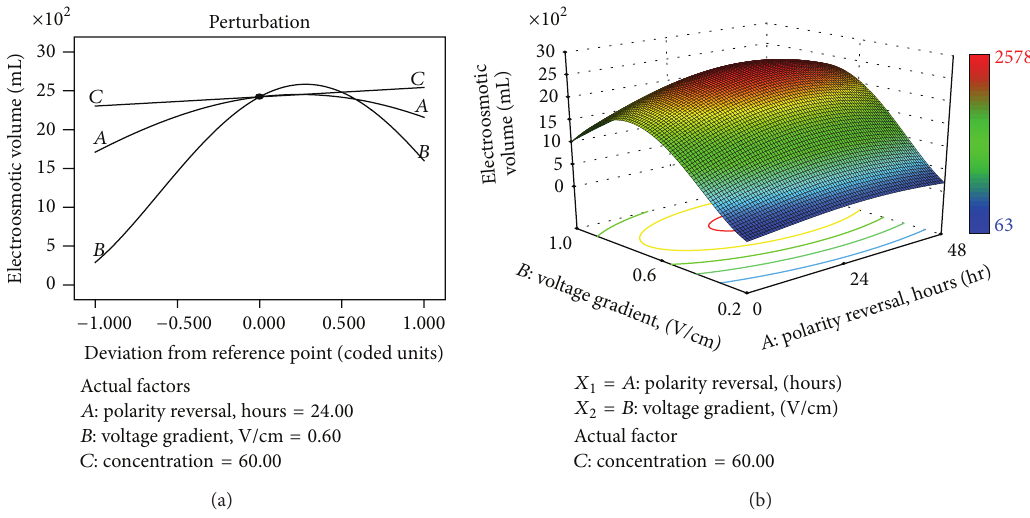
Figure 8: (a) Perturbation plot showing the relative significance of factors on electroosmotic volume. (b) 3D response surface and contour plots showing the influence of voltage gradient on cumulative electroosmotic volume.